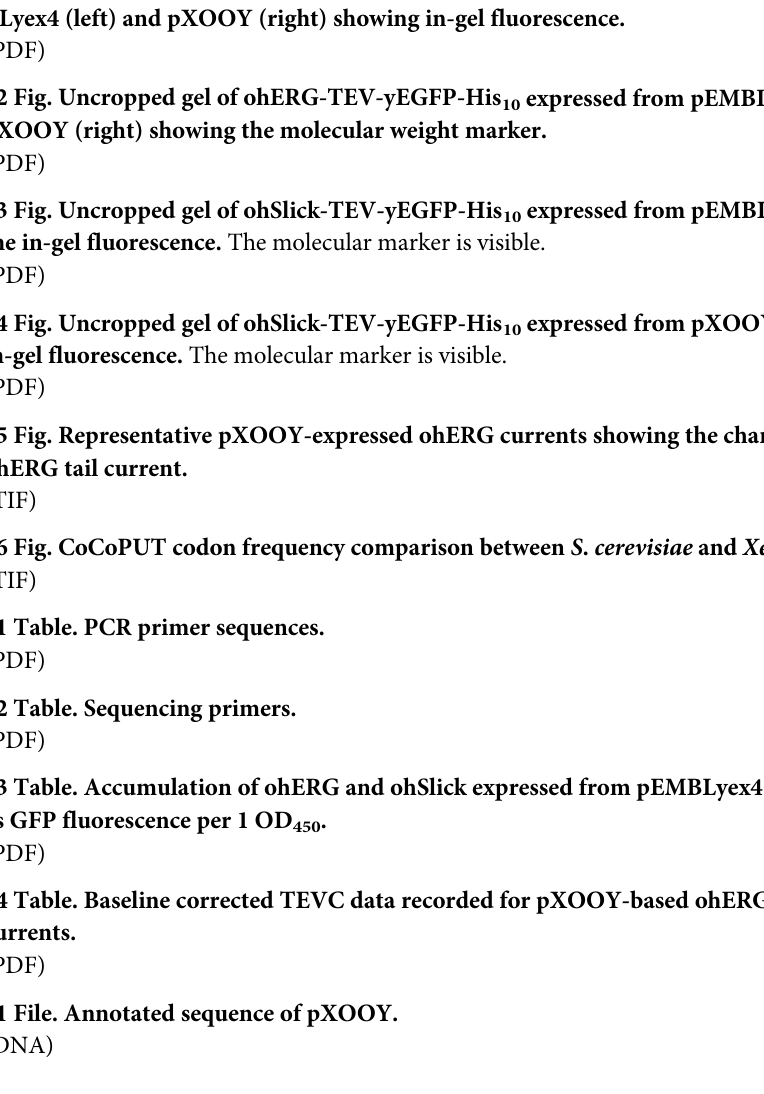
ohERG tail current. S6 Fig. CoCoPUT codon frequency comparison between S . cerevisiae and Xenopus laevis